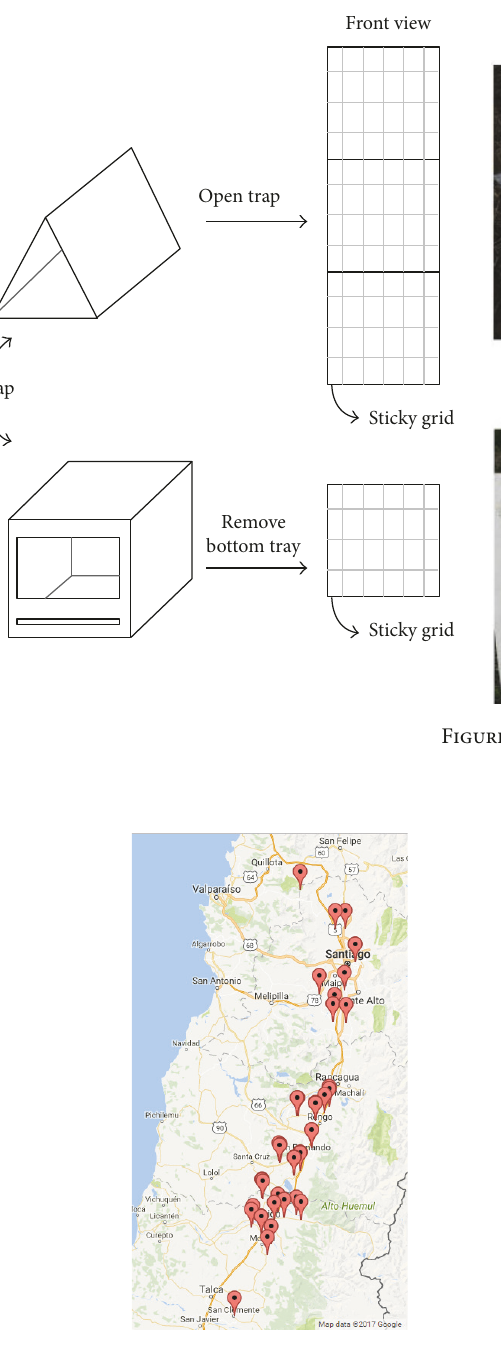
Figure 4: Deployment map between V and VII regions for 50 traps, Chile. Source: Google